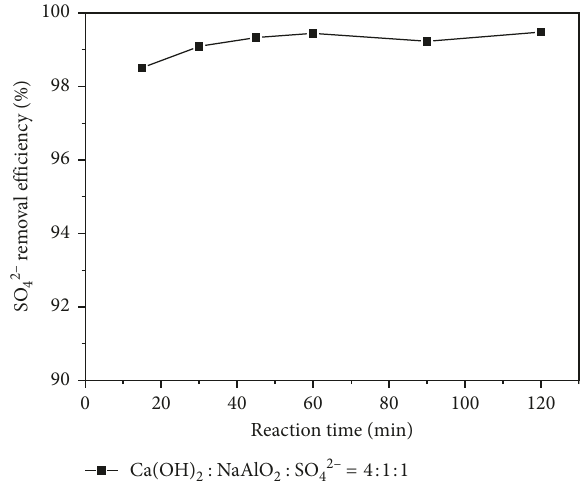
v 200r/min, (cid:27)